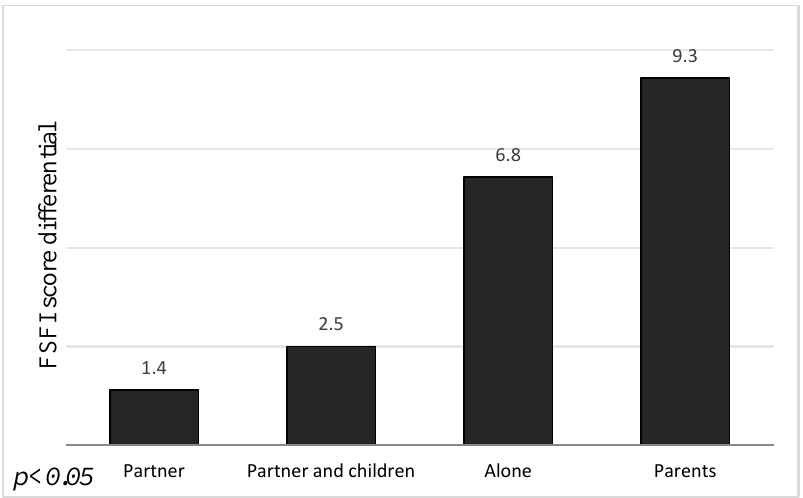
Figure 4. Association between FSFI score differential and type of a housemate.